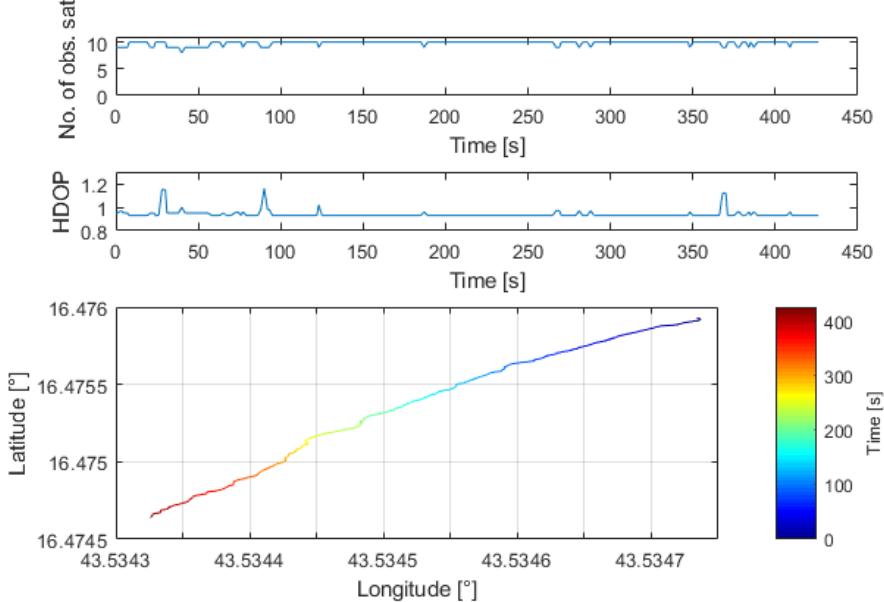
Figure 8. Raw output of the global positioning satellite (GPS) sensor: number of observed satellites ( top ); horizontal dilution of precision (HDOP) ( middle ); and trajectory of the probe in world coordinates ( bottom ) (time is color